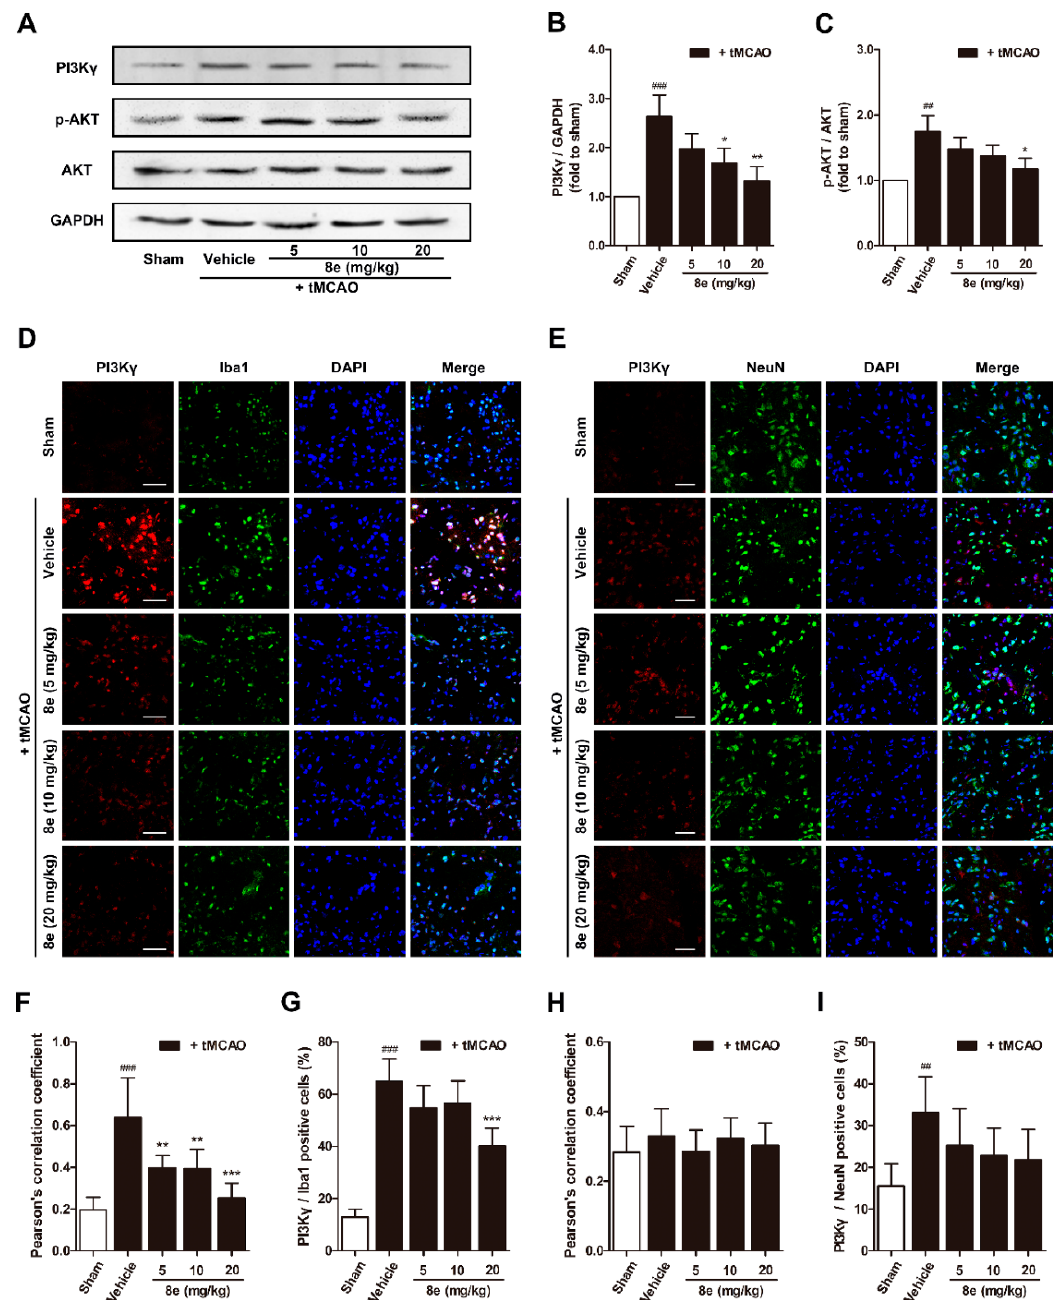
Figure 5. 8e inhibited phosphoinositide 3-kinase gamma (PI3K γ ) signaling in microglia at 72 h after tMCAO in rats. ( A ) Representative bands of Western blot for PI3K γ , AKT and p-AKT in penumbral region; ( B , C ) semiquantitative analysis of PI3K γ and p-AKT protein levels; ( D ) representative confocal fluorescence images of penumbral region labeled with PI3K γ (red), Iba1 (green) antibodies and DAPI (blue). Scale bar = 50 μ m; ( E ) representative confocal fluorescence images of penumbral region labeled with PI3K γ (red), NeuN (green) antibodies and DAPI (blue). Scale bar = 50 μ m; ( F ) Pearson’s correlation coefficients between PI3K γ (red) and Iba1 (green) fluorescence; ( G ) quantitative analysis of the percentage ratios of PI3K γ /Iba1 positive cells to Iba1 positive cells; ( H ) Pearson’s correlation coefficients between PI3K γ (red) and NeuN (green) fluorescence; ( I ) quantitative analysis of the percentage ratios of PI3K γ /NeuN positive cells to NeuN positive cells. Data are presented as mean ± SD ( n = 3). ## p < 0.01, ### p < 0.001 vs. sham group. * p < 0.05, ** p < 0.01, *** p < 0.001 vs. tMCAO + vehicle group.